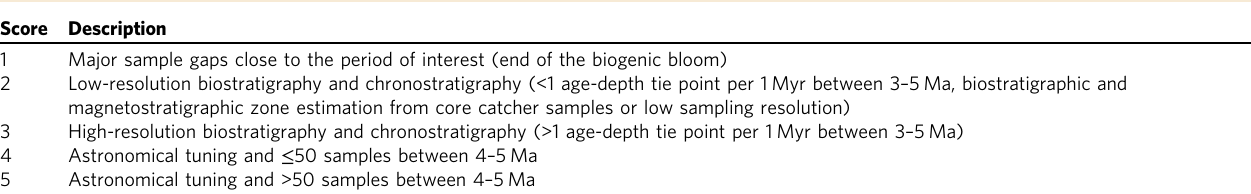
Table 1 Description of the 1 – 5 scoring system for paleoproductivity records evaluated in this